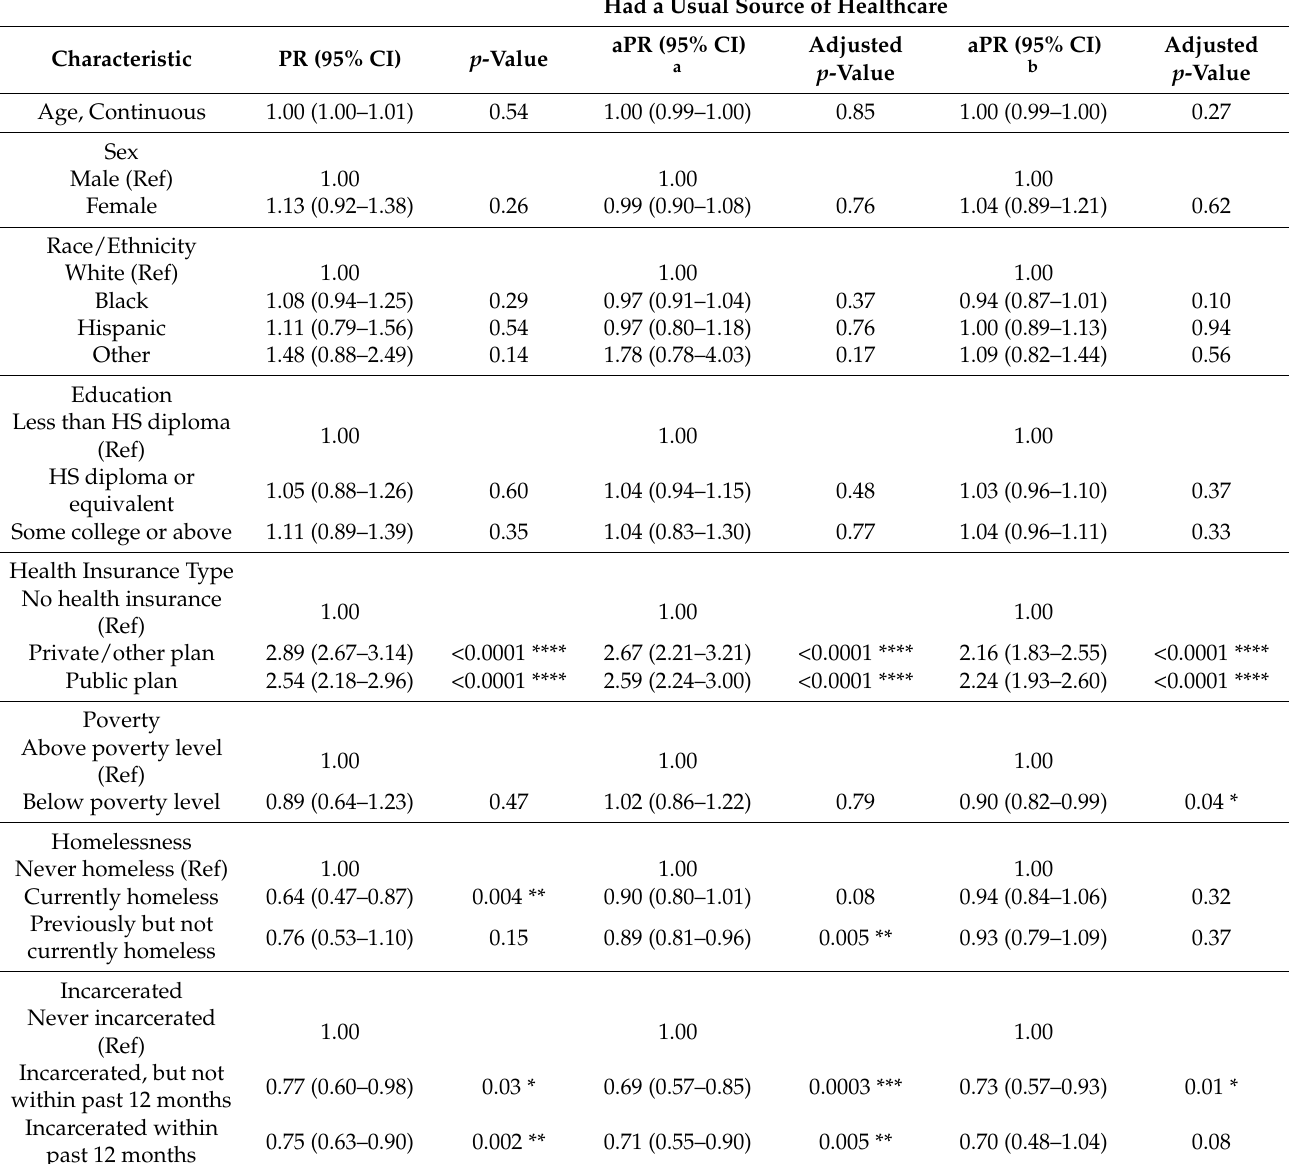
Table 4. Unadjusted and adjusted weighted and unweighted modified Poisson regression models assessing the relationship between usual source of healthcare and sociodemographic characteristics in the study population. Had a Usual Source of